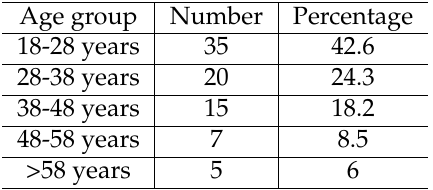
Table 1. Age wise distribution of